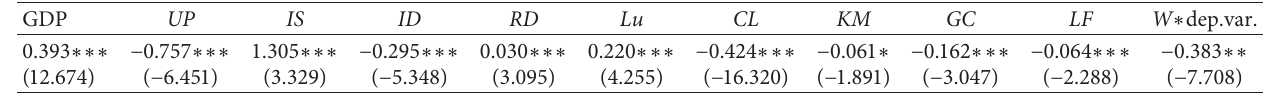
Table 5: Estimation results of fixed-effect spatial lag panel